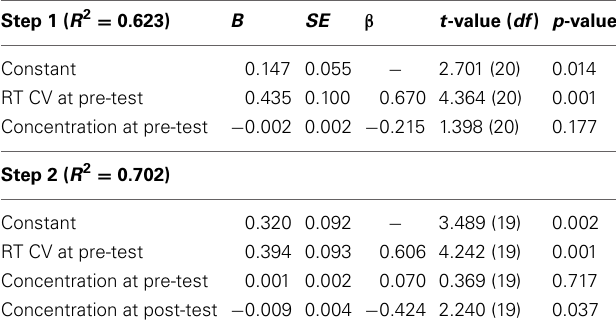
Table 4 | Changes in RT CV predicted by changes in felt concentration (dependent variable is RT CV at